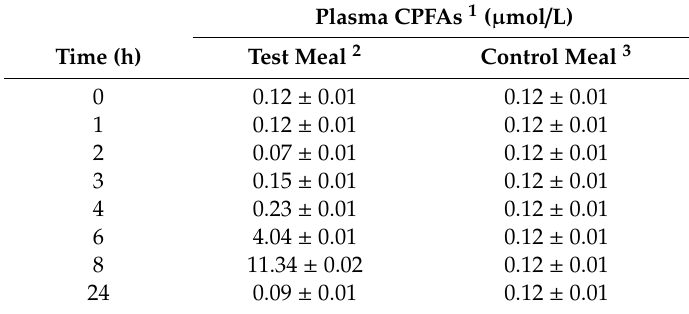
Table 3. CPFAs 1 concentrations in human plasma after a test meal (a single dose of GP) and control meal (without CPFAs).